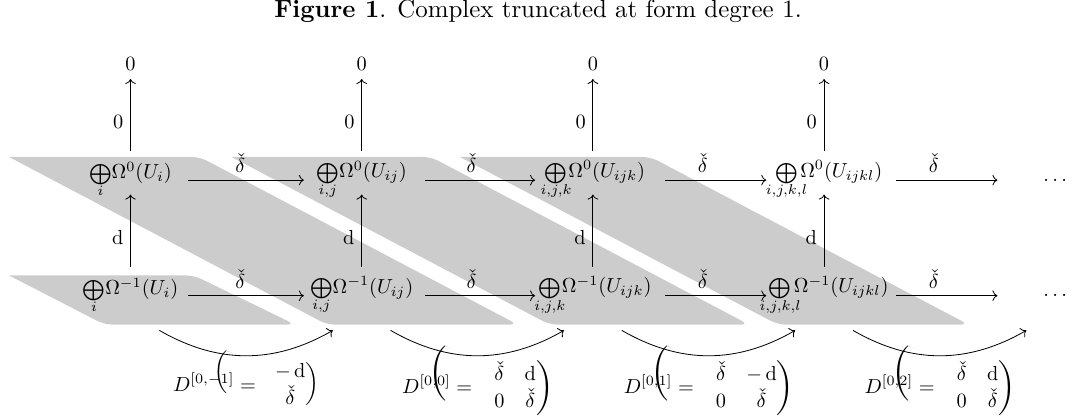
Figure 1 . Complex truncated at form degree 1 .